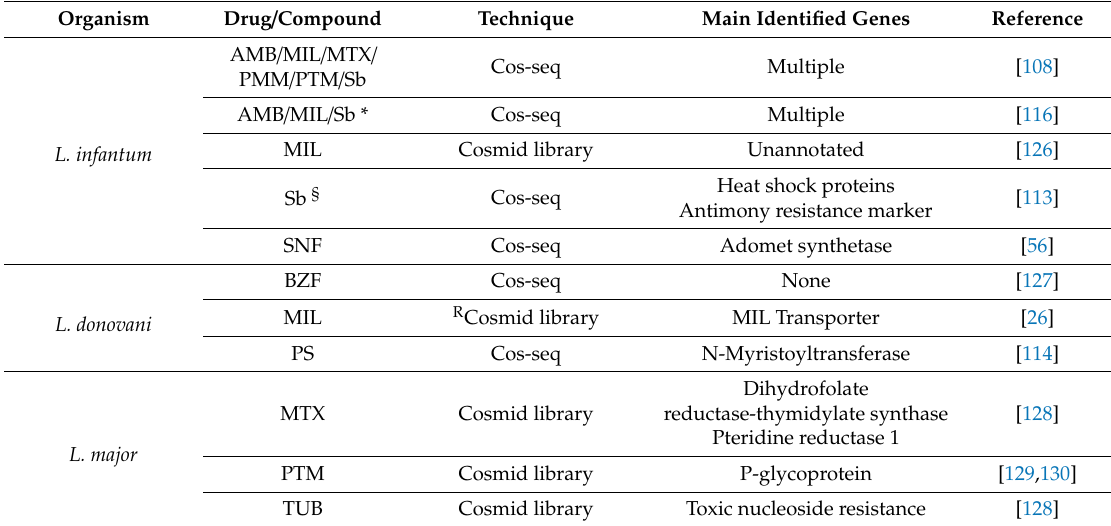
Table 3. Genome-wide expression studies to unravel the MoR or MoA of anti-kinetoplastid drugs. Experiments with Leishmania spp. and T. cruzi were performed on promastigotes and epimastigotes,